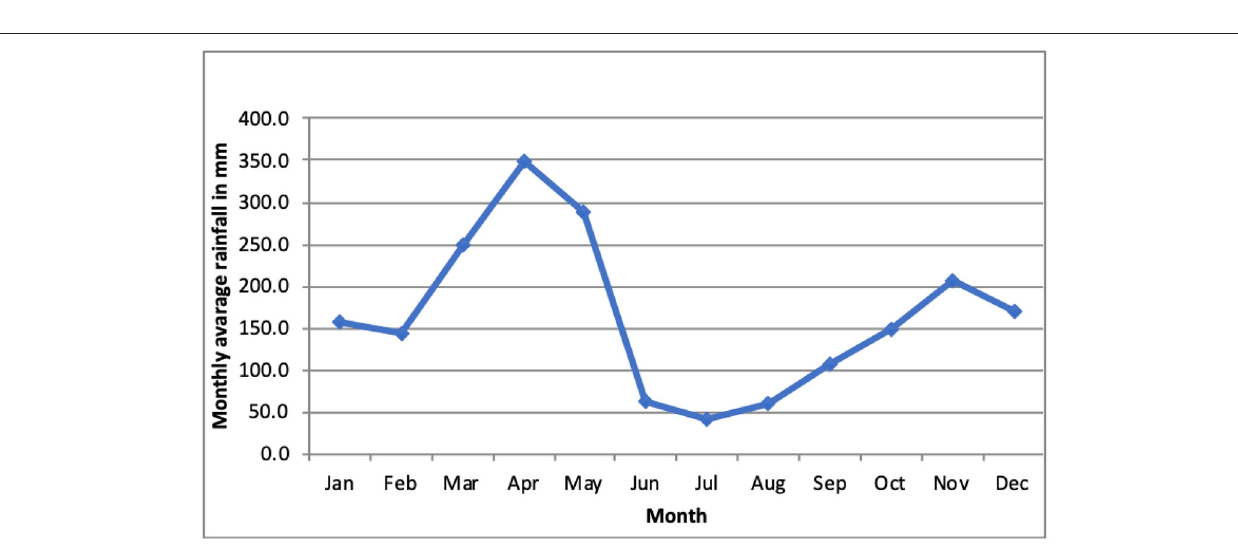
FIGURE 2 | Long-term (1971–2000) observed annual cycle of rainfall in Bukoba, a district of the Kagera